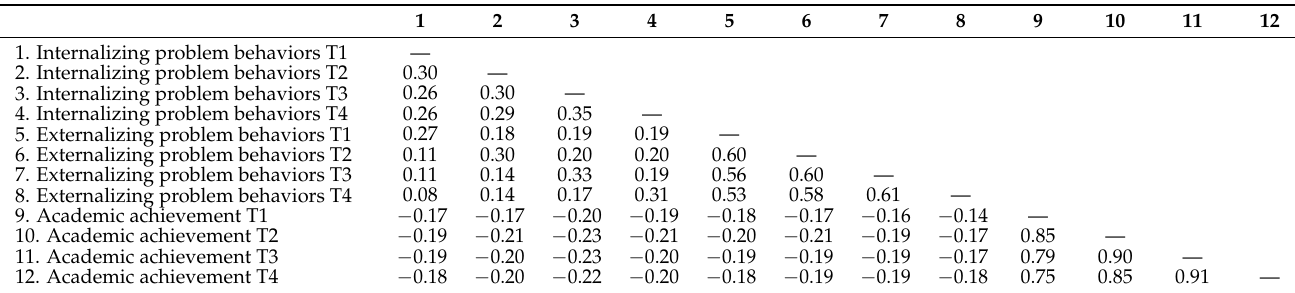
Table 2. Bivariate correlations.